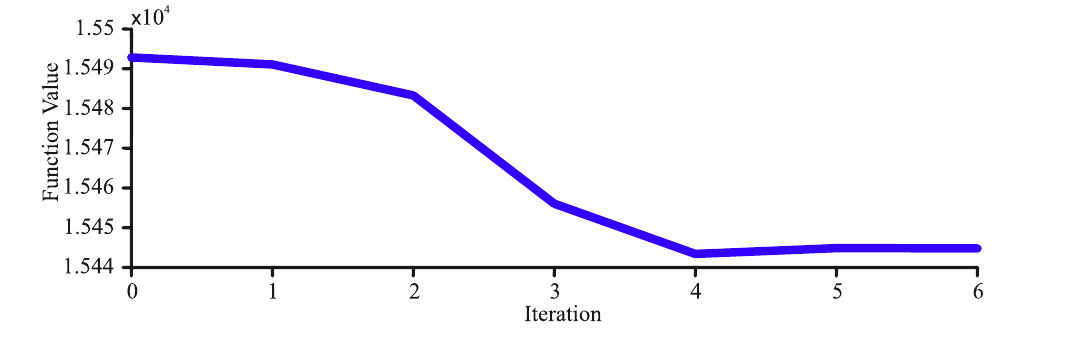
FIG. 1. CONVERGENCE CURVE FOR 6 UNITS TEST SYSTEM TABLE 3. OPTIMAL GENERATION AND COST (15 UNITS TEST